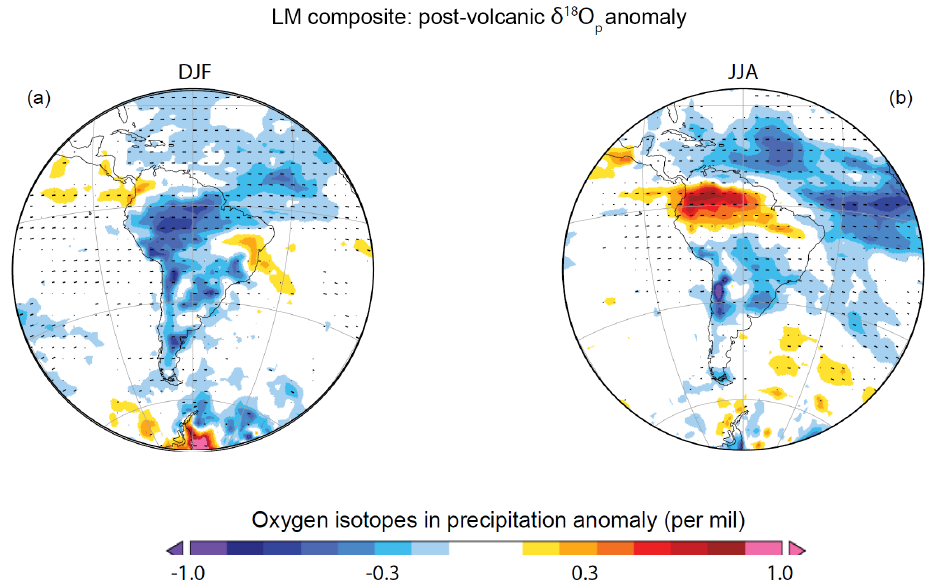
Figure 10. Last millennium post-volcanic oxygen isotope in precipitation ( (cid:49)δ 18 O p ) composite (per mil) with all eruption events during (a) DJF and (b) JJA from GISS ModelE2-R using procedure described in the text. Stippling highlights areas with anomalies significant at p< 0 . 1.